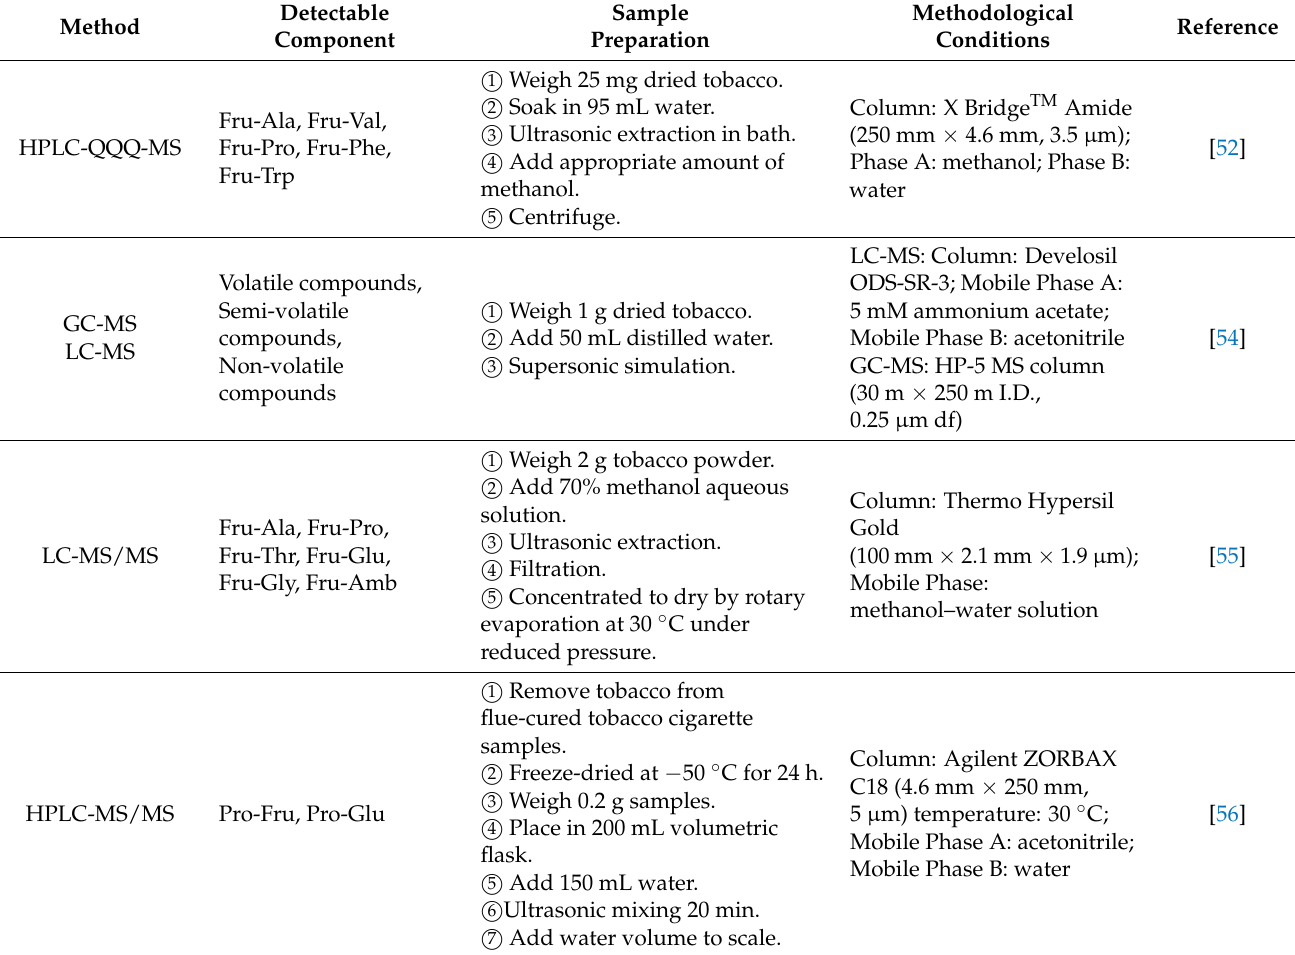
Table 1. Methods for determining Maillard product in tobacco